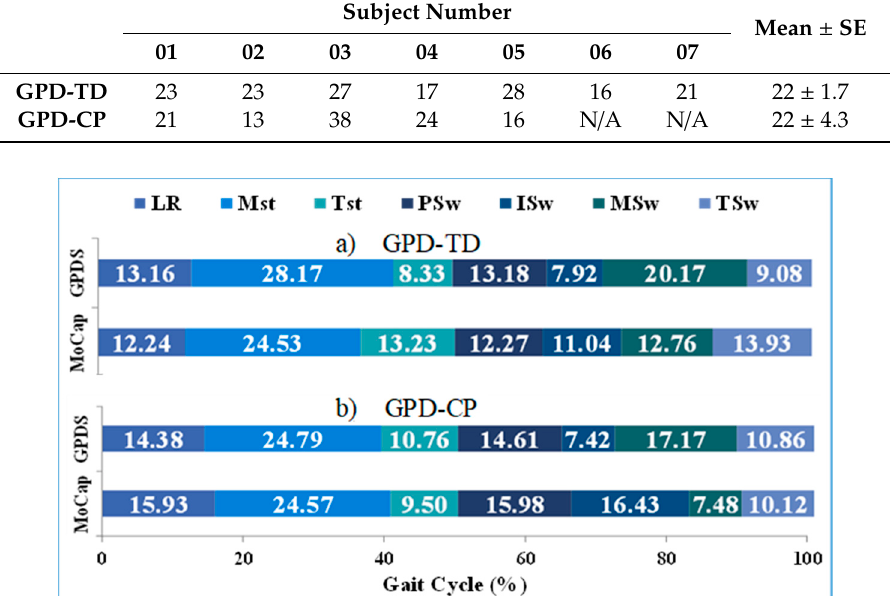
Table 4. Gait cycle duration RMSE relative to motion capture for both the typically developing version of the GPD algorithm (GPD-TD) and for the version of the GPD algorithm used for participants with CP (GPD-CP). Times are in ms.